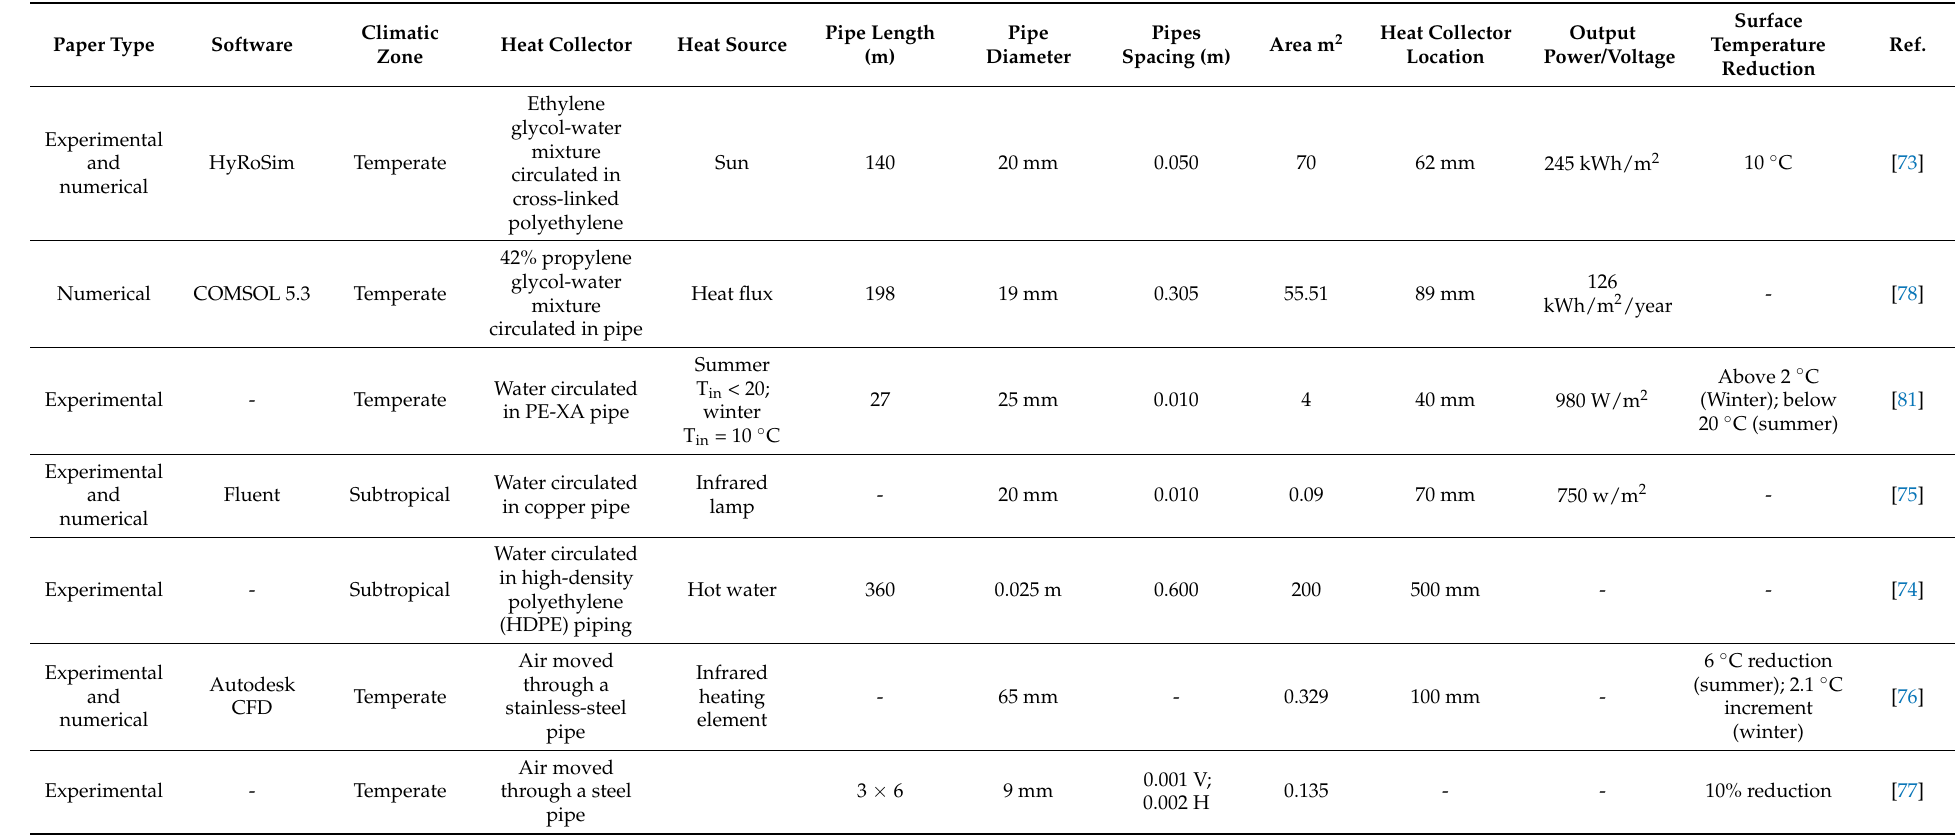
Table 4. Summary of the Previously Published Studies Using the PSC